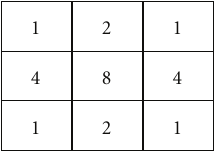
steady the view. And this makes the brain su ff er. After a while, the muscles start to ache and the nerves begin to pain. And this unbalanced image pair may even result in amblyopia for a very long-term viewing